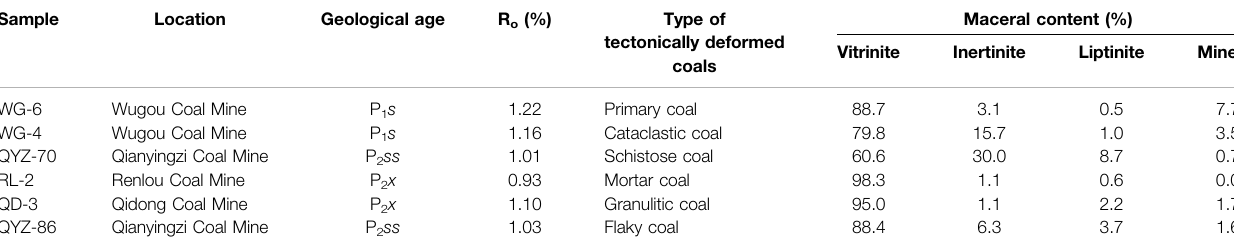
TABLE 1 | General information of coal samples.